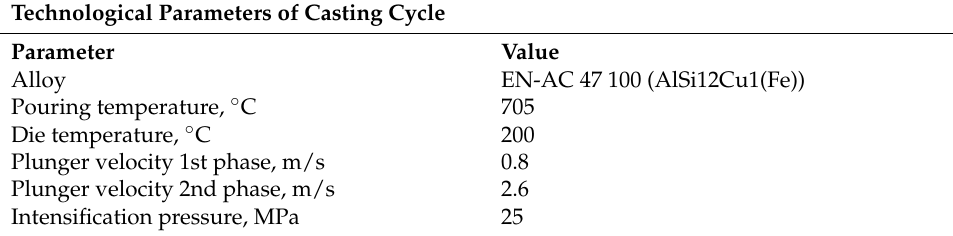
Table 2. Technological parameters of casting